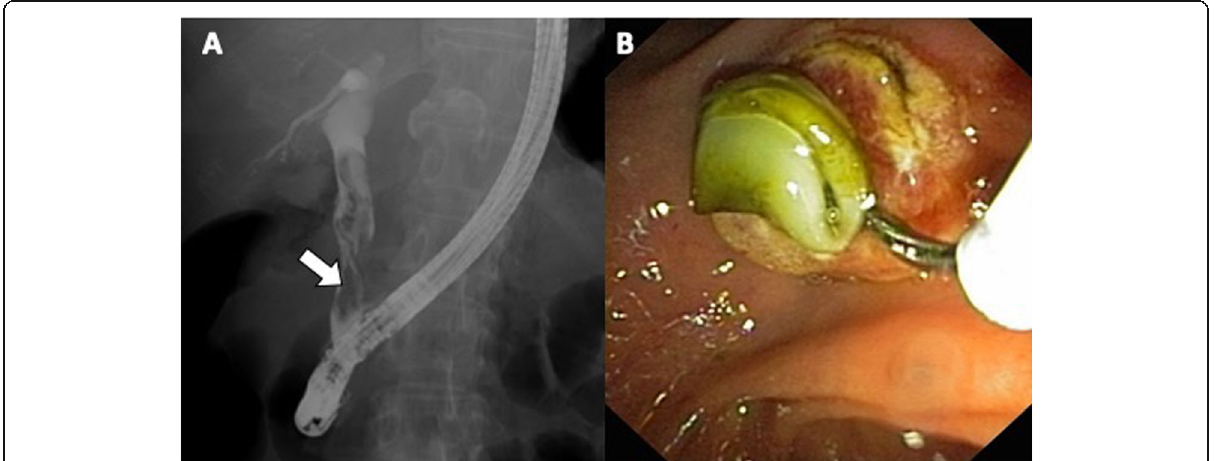
Fig. 7 A 65-year-old woman with cysto-biliary rupture. a Radiographic image performed during ERCP procedure shows multiple filling defects into the common bile duct (arrow), representing hydatid membranes. b Endoscopic image of the same patient shows hydatid membranes extraction